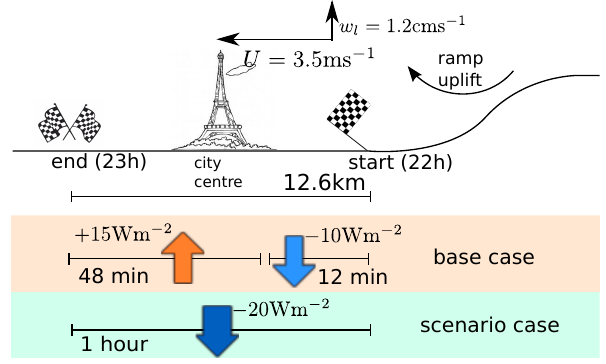
Fig. 11. Overview of the idealized advection model set-up over Paris for the base case and the scenario case. Surface sensible heat fluxes, horizontal and vertical wind speed and duration of simula- tion are shown.